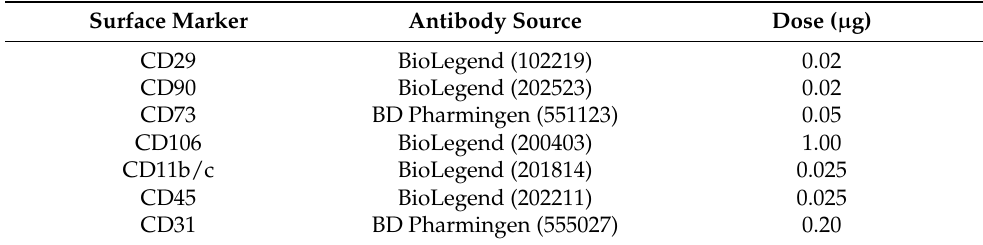
Table 1. List of surface markers in characterization panel, including antibody source and respective dose per 1 × 10 6